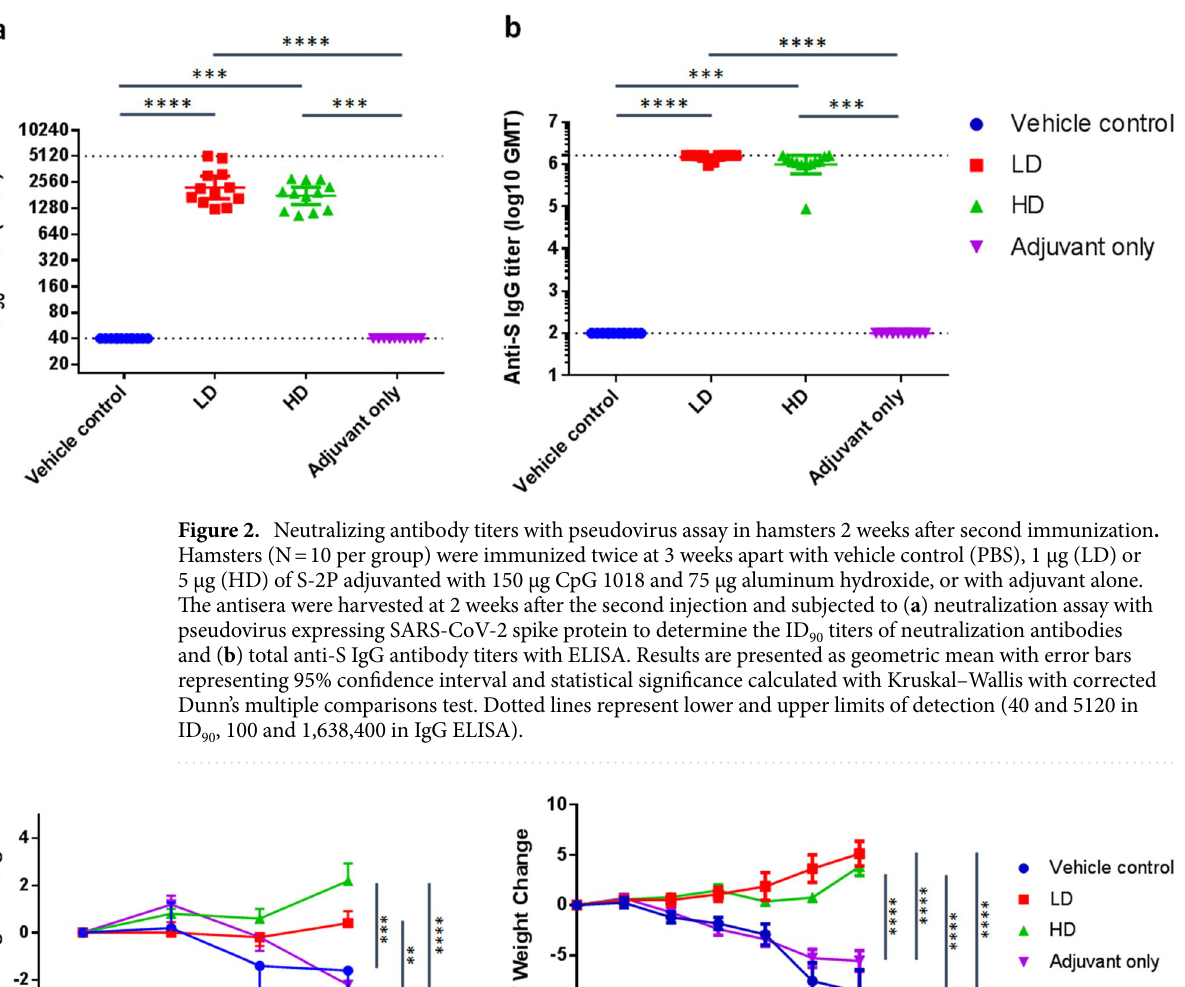
virus and body weights were tracked up to 3 or 6 days post infection (d.p.i.). Groups of animals were sacrificed on 3 or 6 d.p.i. for viral load and histopathology analyses (Fig. 1). LD and HD vaccinated groups did not show weight loss up to 3 or 6 days after virus challenge and instead gained 5 and 3.8 g of mean weight at 6 d.p.i., respectively (Fig. 3). The protective effect was most significant at 6 d.p.i. in both vaccinated groups, while vehicle control and adjuvant only groups experience significant weight loss (Fig. 3). Lung viral load measured by viral RNA and TCID 50 assays showed that both viral RNA and viral titer decreased significantly at 3 d.p.i. in vacci- nated hamsters and dropped to below the lower limit of detection at 6 d.p.i. (Fig. 4). Note that viral load, espe- cially viral titer measured by TCID 50 dropped noticeably at 6 d.p.i. in control and adjuvant only groups due to hamsters’ natural immune response (Fig. 4). Lung sections were analyzed and pathology scoring was tabulated (Fig. 5). There were no differences at 3 d.p.i. between control and experimental groups; however, at 6 d.p.i., the vehicle control and adjuvant only groups had significantly increased lung pathology including extensive immune cell infiltration and diffuse alveolar damage, compared to the HD antigen/adjuvant immunized groups (Fig. 5; Fig. S6). These results showed that MVC-COV1901-induced robust immunity was able to suppress viral load in lungs and prevent weight loss and lung pathology in infected hamsters.